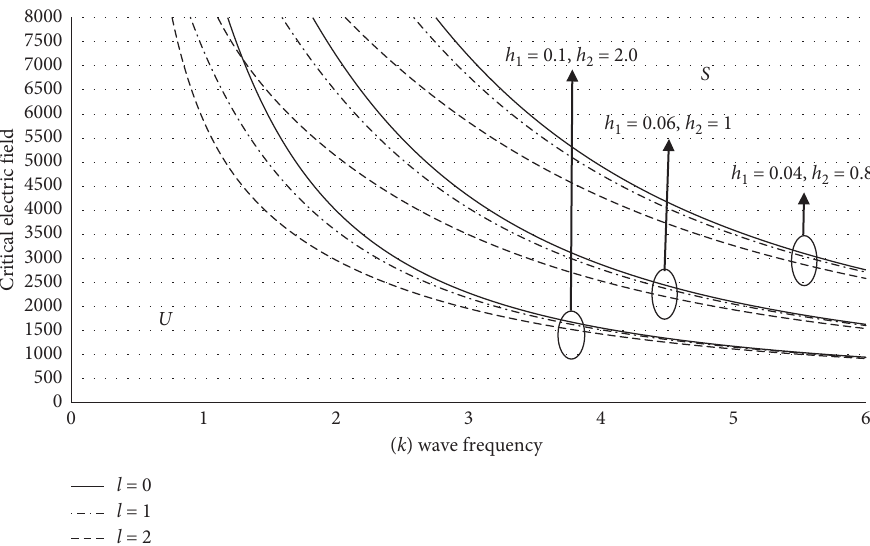
Figure 7: Variation of E 2